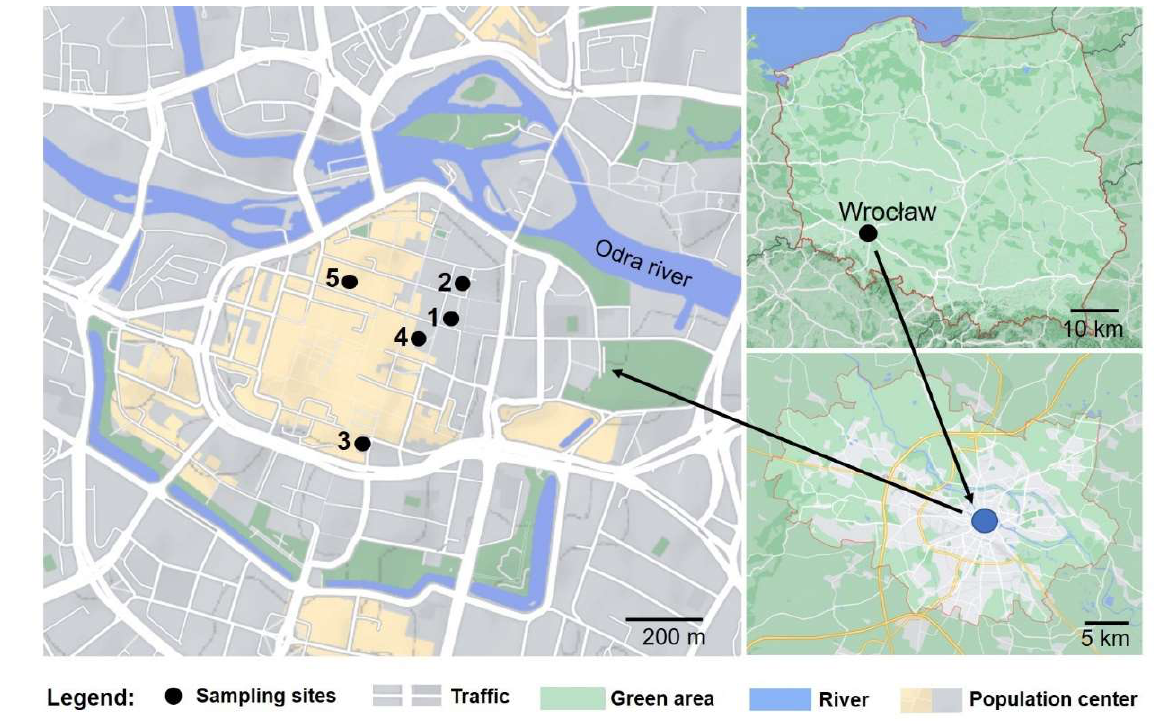
Figure 1. Location map of investigation area in the center of Wrocław: sampling sites: (1) 5 Kotlarska St., (2) 2–4 Jodłowa St., (3) 78–80 Szewska St., (4) Łaciarska St. (backyard), (5) 21 Kotlarska St.